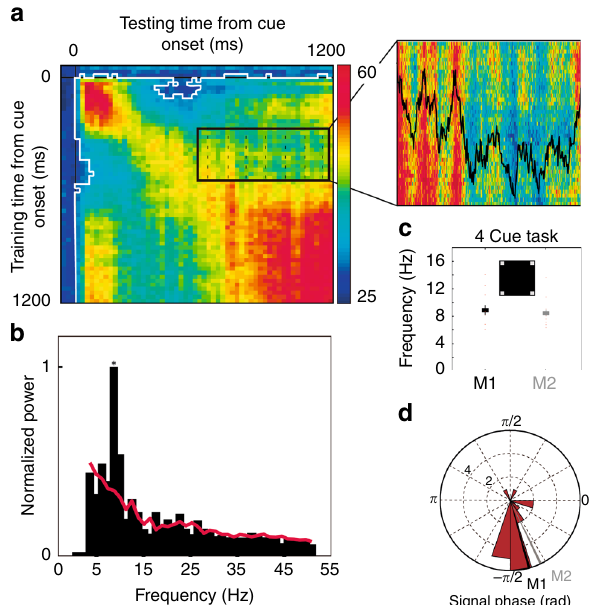
Fig. 2 Oscillation of prefrontal attention-related information. a Cross- temporal classi fi cation around cue presentation ([ − 100: 1200 ms], step of 10 ms, averaging window of 50 ms) for an exemplar session. White contour: 95% con fi dence interval as assessed from trial identity random permutation. Black contour: close-up of the cross-temporal classi fi cation ([testing time: 500 – 1150 ms] post-cue; training time: [400 – 575 ms]) and corresponding mean classi fi cation along testing time (black). b Normalized power in this cross-temporal classi fi cation interval, (red line: 95% con fi dence interval) for the exemplar session presented in ( a ). c Average + / − s.d. of peak power in a 7 – 12 Hz interval, over all sessions, for each monkey (M1: black, M2: gray), in the 4-cued locations task version, individual data points plotted in red. d Circular distribution of signal phase with respect to cue onset (red bars), at identi fi ed peak frequency (mean phase: M1: black, − 75°, M2: gray, −